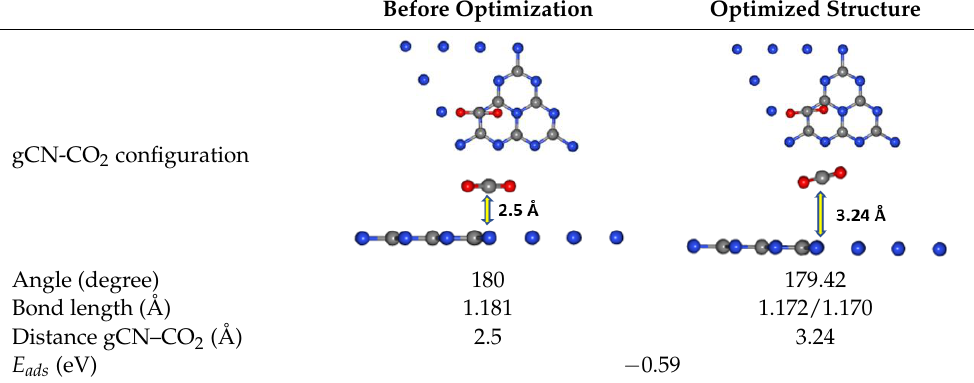
Table 2. Structural comparisons after adsorption of CO 2 at the surface of gCN and their adsorption energy. Before Optimization Optimized Structure